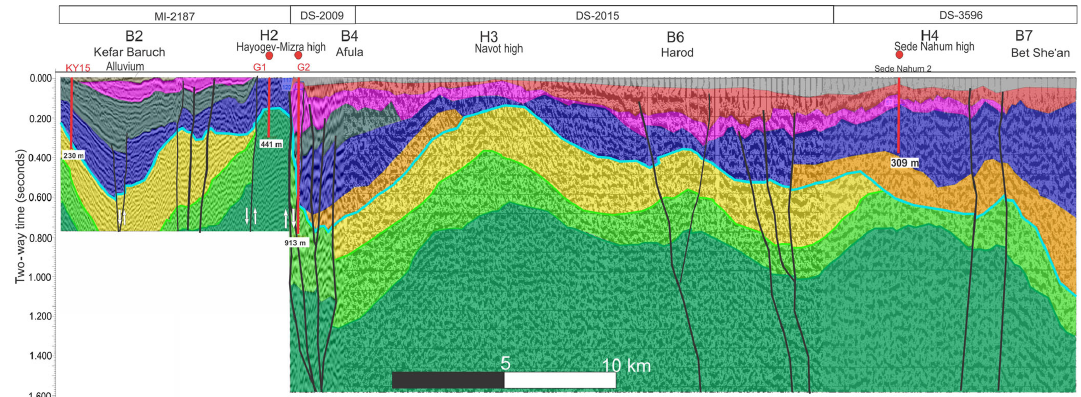
Figure 9. Multichannel seismic reflection profile across basins B2, B4, B6, and B7 (lines MI-2187, DS-2009, DS-2015, DS-3596). The RTS horizon (celeste) divides pre-truncation from post-truncation sediments. The Hayogev-Mizra high (HMH) intervenes between the Kefar Baruch and Afula Neogene basins. Cretaceous units at the syncline (Kefar Baruch, B2) and in the eastern B7 area were interpreted using intersecting and overlapping deeper seismic profiles from the DS series. Location: Fig. 3; unit color code – Fig. 2. No vertical